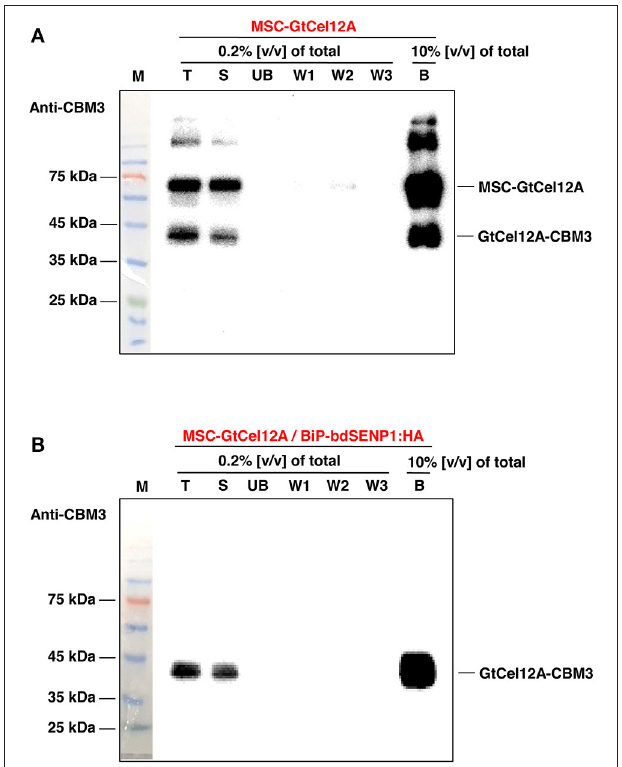
FIGURE 3 | Purification of MSC-GtCel12A from the N. benthamiana leaf extracts. (A,B) To purify CBM3-fused GtCel12A, 4 grams of leaves harvested 7 days after agro-infiltration were used as described in the Materials and Methods. Total protein extracts were incubated with MCC beads. After centrifugation, the supernatant fraction was collected as unbound (UB) fraction. Next, the MCC beads were washed three times with a wash buffer. Finally, MCC bead-bound GtCel12A was eluted by boiling with protein sample buffer. T, total protein extracts; S, soluble fraction used to incubate with the MCC beads; UB, unbound fraction; B, MCC bead-bound fraction.